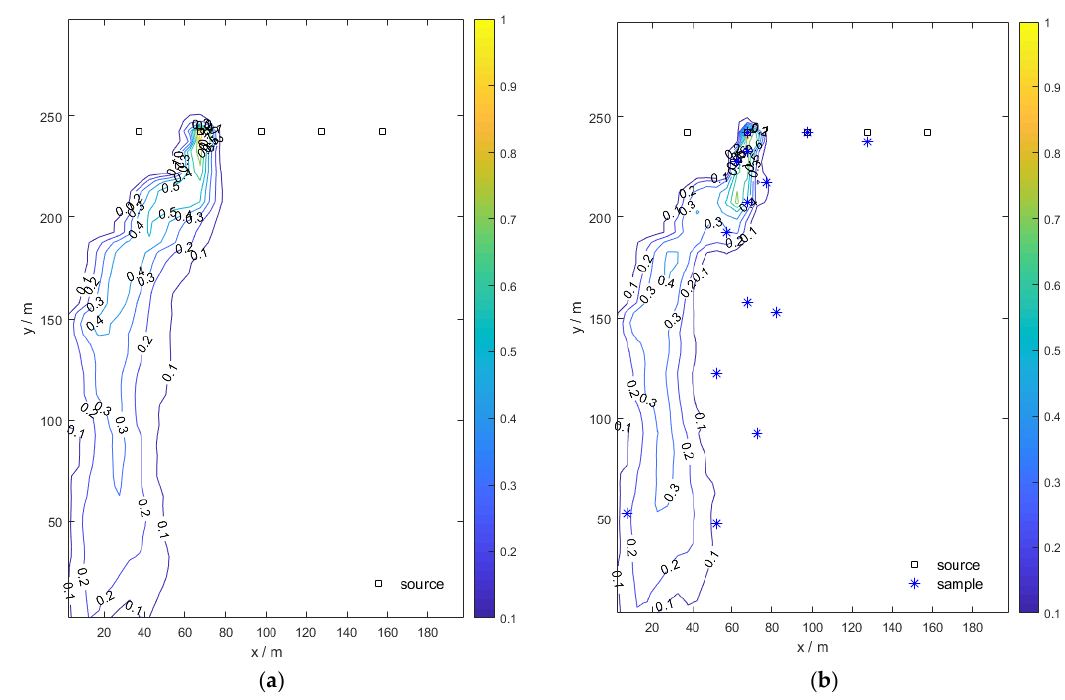
Figure 10. The normalized contour map of the pollution plumes: ( a ) True plume. ( b ) Superposed plume after the Kalman filter (14 points) of the moderate heterogeneity case.